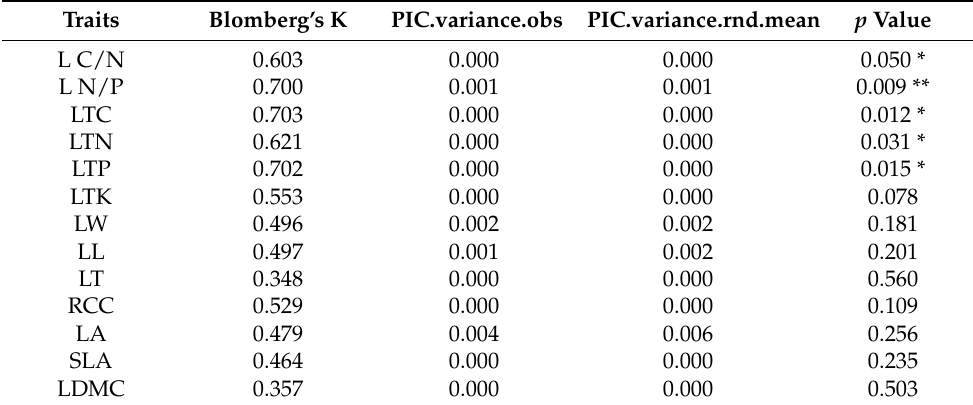
Table 1. Phylogenetic signal intensity of functional traits.